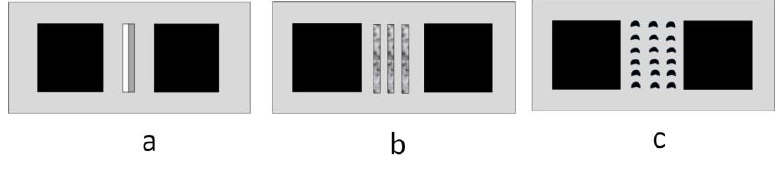
Fig. 1. External field correction elements: a – prism, b – absorption strips, c – “mushroom” rods